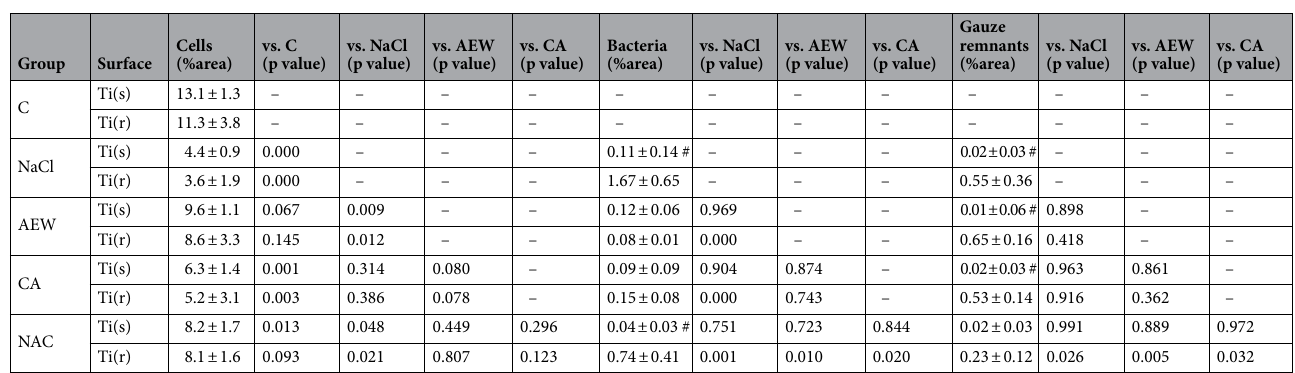
Table 1. Mean %area of cells, bacteria and gauze deposit on titanium surfaces per SEM images at 2000 × magnification. # indicates a significant difference ( p < 0.05) between disc categories. All p values based on multiple regression analysis. Six discs (3 Ti(s) & 3 Ti(r)) per group, total n = 30